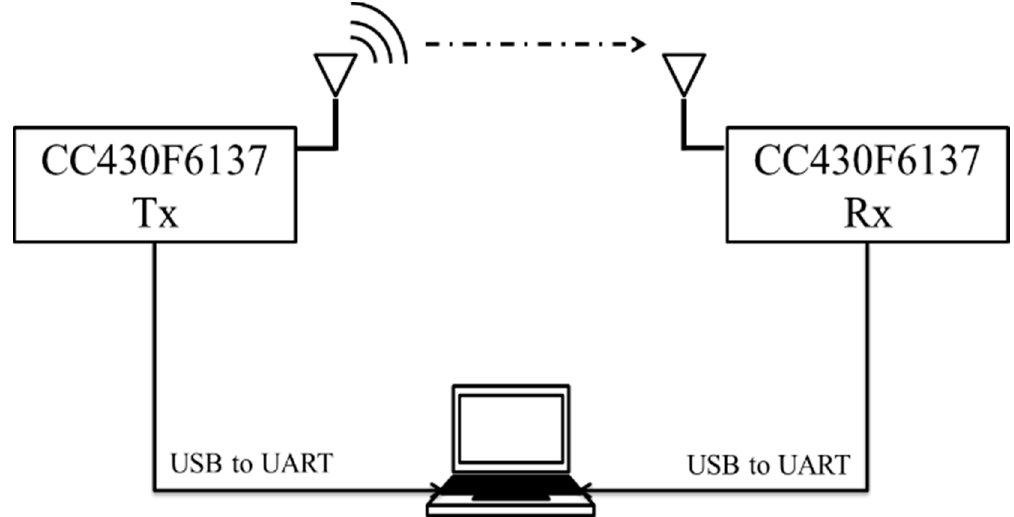
Figure 5. Experimental architecture of receiver sensitivity. Sensors 2020 , 20 , x